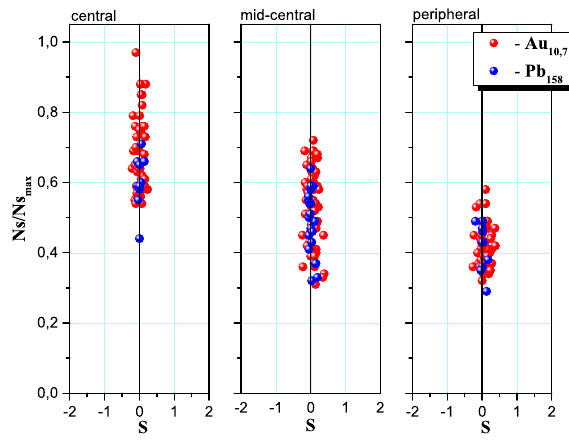
Figure 2. E-by-E accuracy (S) analysis for (Au, Pb) + (Ag / Br) interactions